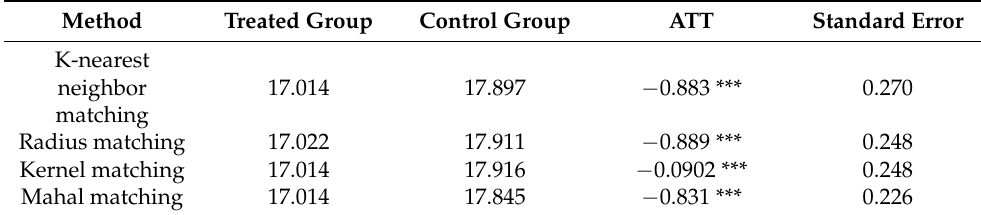
Table 5. Average treatment effect of employment on the mental health of older